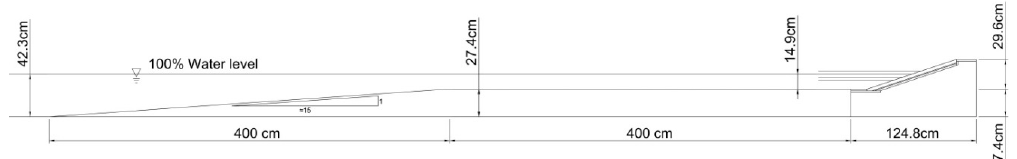
Figure 1. Foreshore and structure geometry in the wave flume.